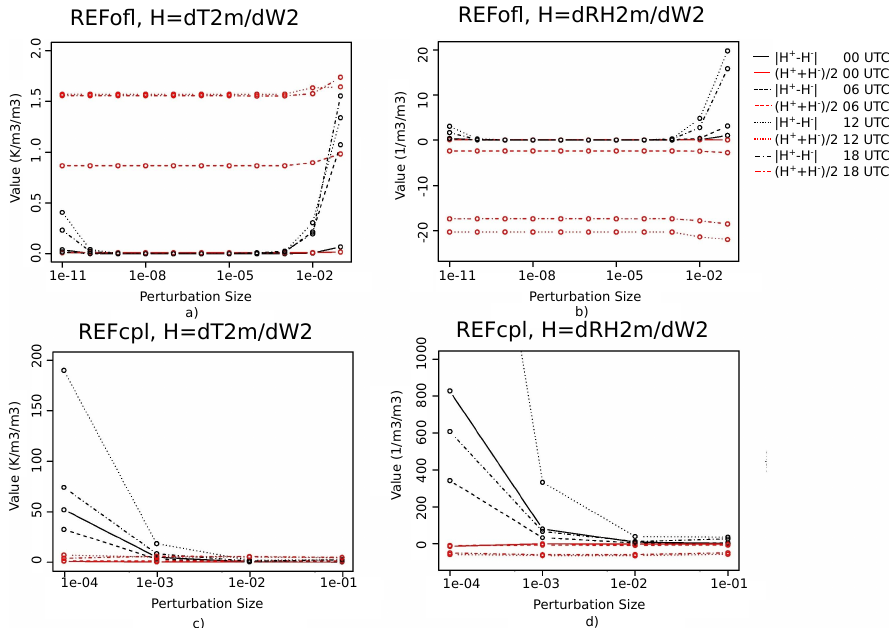
Figure 8. Comparison of the optimal perturbation size for the offline (top) and coupled (bottom) approaches. | H + − H − | (black) and H + + H − / 2 (red) for different perturbation sizes on 2 July 2010 at 00:00, 06:00, 12:00 and 18:00UTC averaged over the whole domain with H = δT 2m /δW 2 (left) and H = δ RH 2m /δW 2 (right).